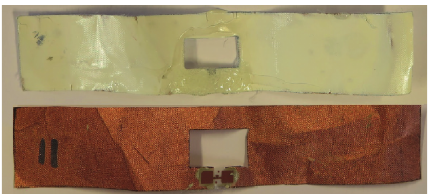
Figure 5: Noncoated (lower) and coated (upper) copper fabric tags.